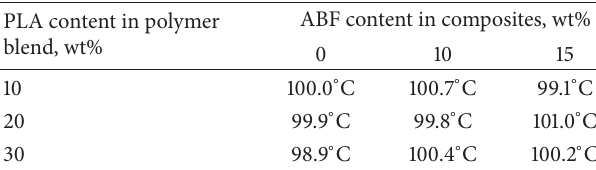
Table 4: 𝑇 𝑐 of PLA in polymer blends and composites. PLA content in polymer